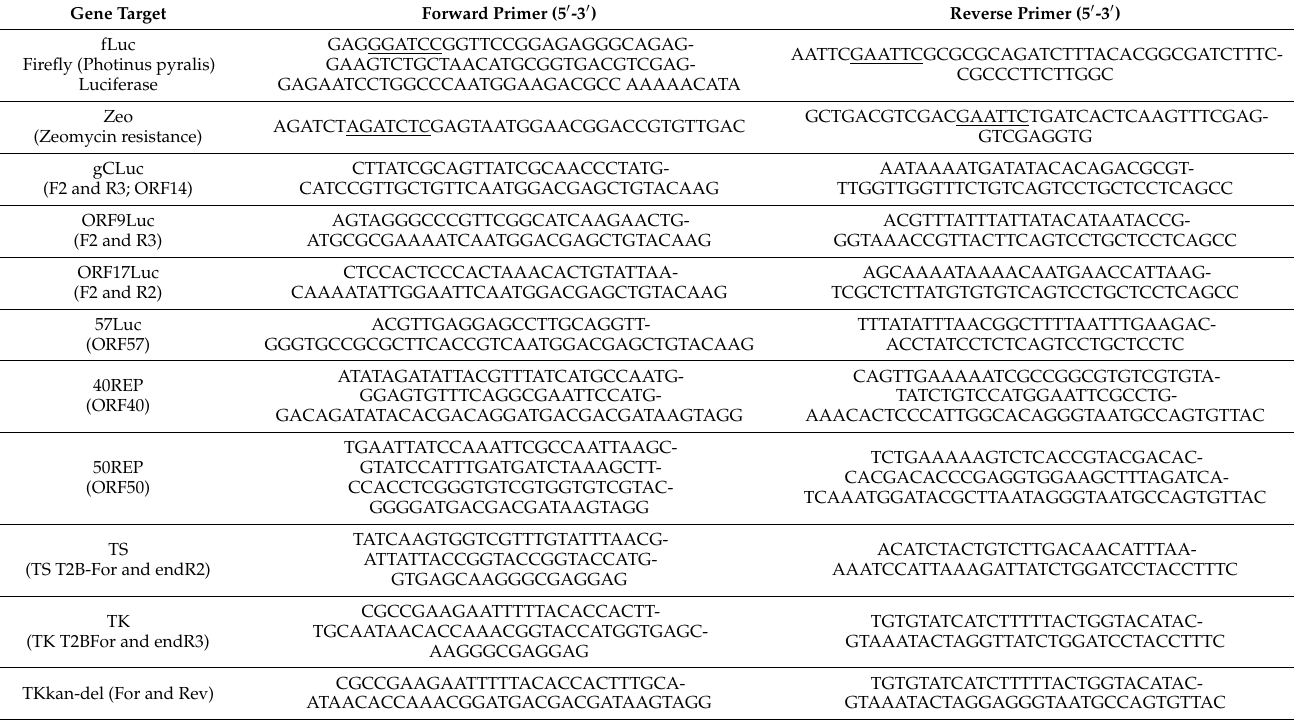
Table 1. Primers used to generate VZV